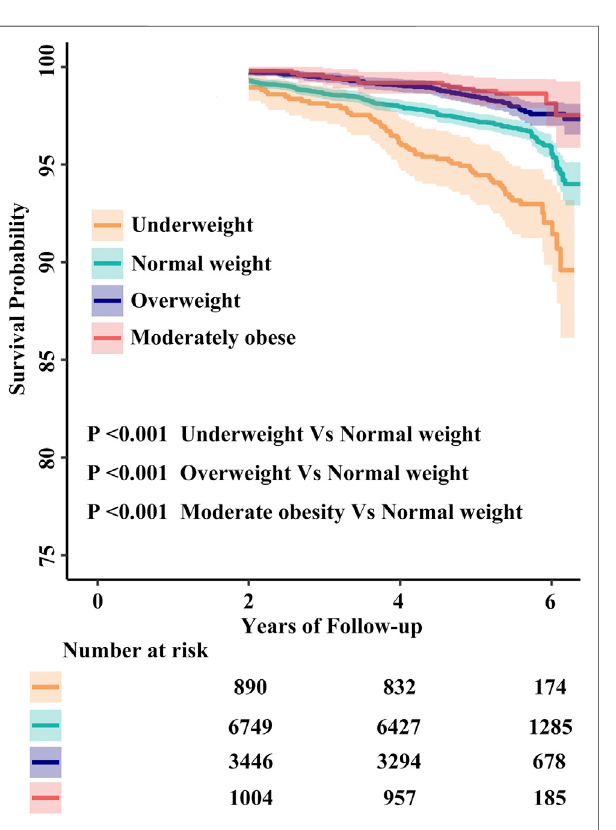
Frontiers in Physiology |